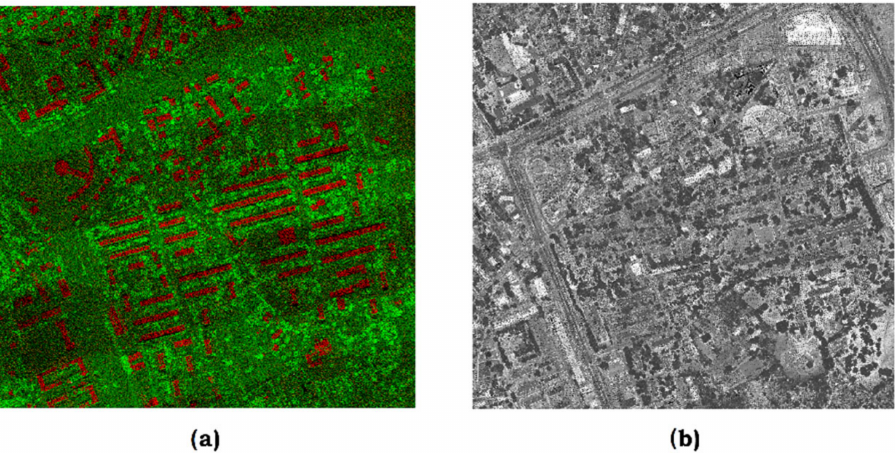
Figure 3. LiDAR point clouds in orthogonal projection: ( a ) displayed by point classification from 2006, ( b ) displayed by intensity attribute from 2012. Table 1. Specific characteristics of the study data (AP—aerial photograph, LD—LiDAR data, BDOT10k—topographic object